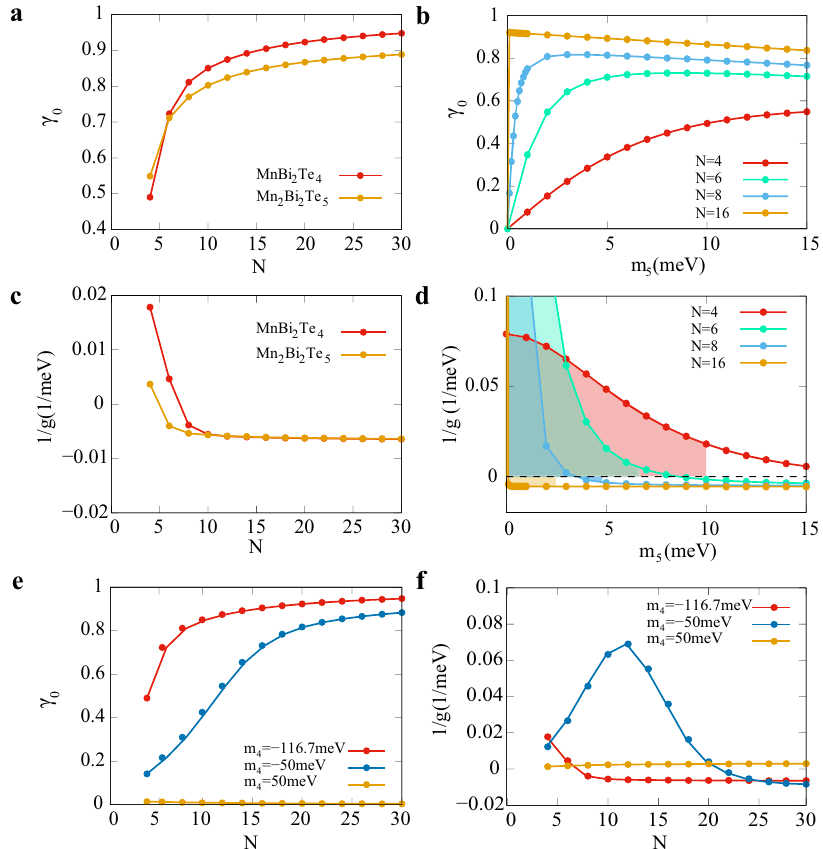
Fig. 3 Dynamical magnetoelectic effect. a , c The ME quantity γ 0 ( a ) and 1/ g ( c ) versus the thickness with N bi-SLs for MnBi 2 Te 4 (red) and NLs Mn 2 Bi 2 Te 5 (yellow) thin fi lms, where values of m 5 are obtained from fi rst-principles calculations. b , d γ 0 ( b ) and 1/ g ( d ) as a function of m 5 for fi lms with different thickness ( N = 4, 6, 8, 16). The shaded regions in ( d ) denote the substantially tunable range 1/ g of realistic MnBi lms by decreasing m 5 with increasing temperatures up to the N ée l temperature. e , f γ 0 ( e ) and 1/ g ( f ) as a function of the thickness ( N bi-SLs) of fi lms for three representative values of the mass term m 4 , where negative (positive) m 4 represents topologically nontrivial (trivial) band structure with (without) the band inversion. The mass term m 4 can be tuned through the element substitution of Mn(Bi 1 − x Sb x ) 2 (Te 1 − y Se y ) 4 .